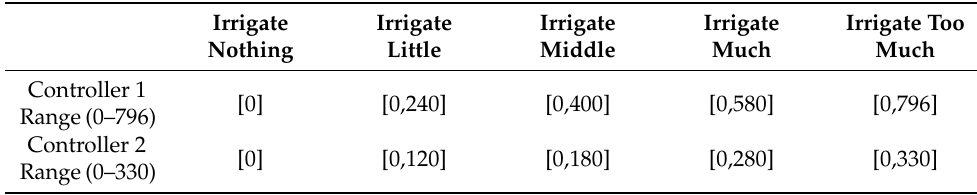
Table 6. Controller outputs fuzzy